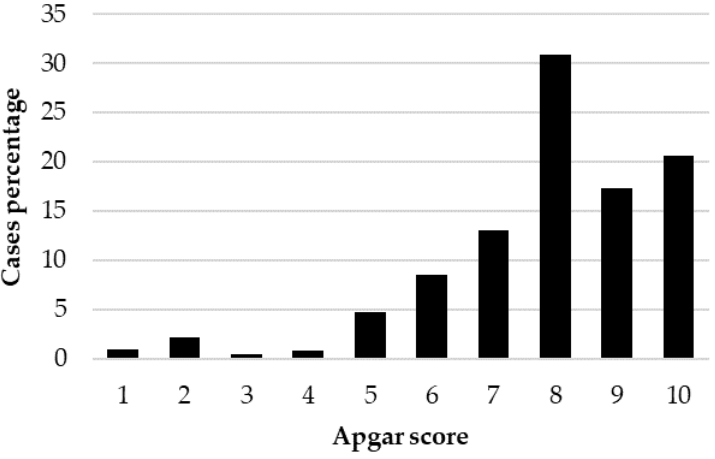
Figure 4. Distribution of the Apgar score (case percentage) in the 578 large-sized live-born puppies. The distribution, expressed as a number and (%), of the 1039 live-born puppies in the viability classes according to the BBS is reported in Table 6. Table 6. Distribution (expressed as number and %) of the 1039 live-born puppies in the viability classes according to the BBS.